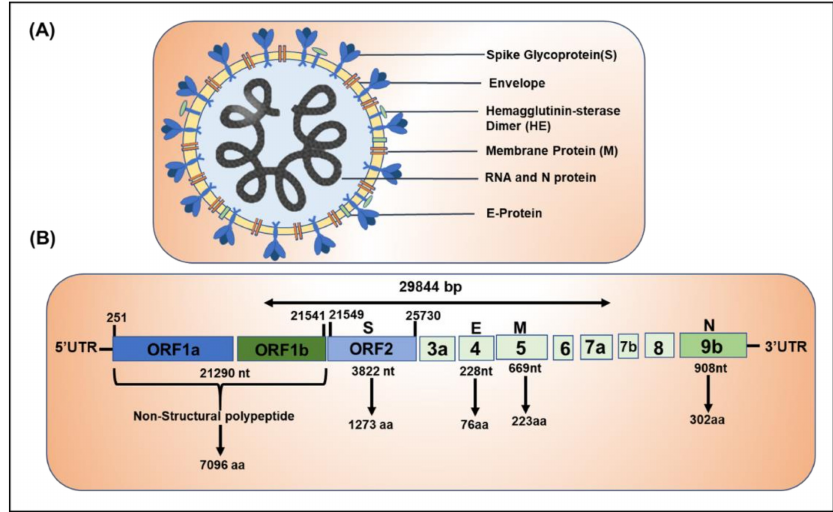
Figure 2. Typical ultra-structure and genome organization of SARS-CoV-2. ( A ) Illustration of SARS-CoV-2 showing key components of the virus morphology. The virus contains several crown or club shaped glycoprotein spikes (S) on the outer membrane used for anchoring to host cell, lipid bilayer spanning membrane protein (M), hemagglutinin esterase (HE) in the envelope, which has enzymatic activity that weakens the host defense, envelope (E) and the genetic material RNA and nucleoprotein (N). ( B ) Genomic organization of novel SARS-CoV-2. The genome of SAR-CoV-2 is approximately 2.9 kb in size. The first ORF1 (2.1 kb) codes for two (Frameshift) non-structural polypeptide pp1a and pp1b (weighs-7.09 KD) and several non-structural proteins (nsps). Four major structural proteins are coded from di ff erent ORFs (1) spike (S), (2) envelope (E), (3) membrane (M), and (4) nucleocapsid